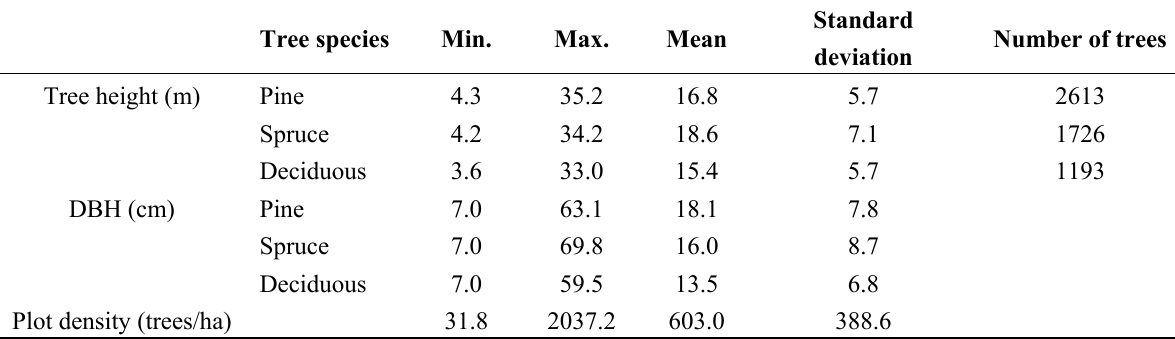
Table 1. Summary of the field measurements data for the 292 sample plots (5532 trees) located in the study